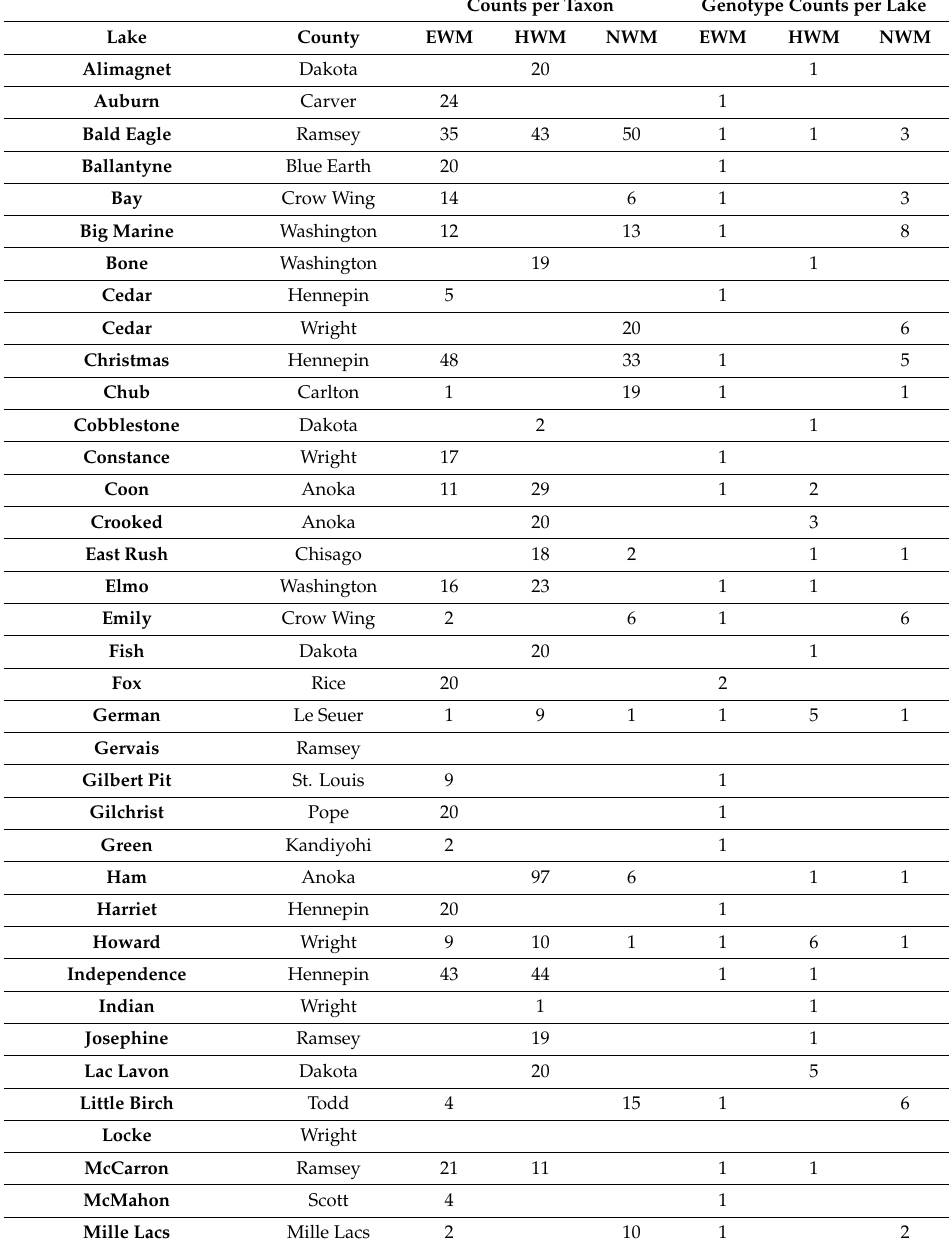
Table A3. Summary of genetic analyses of lakes surveyed. The number of each taxon identified from samples collected in each lake is presented and the number of distinct genotypes is indicated for each taxon in each